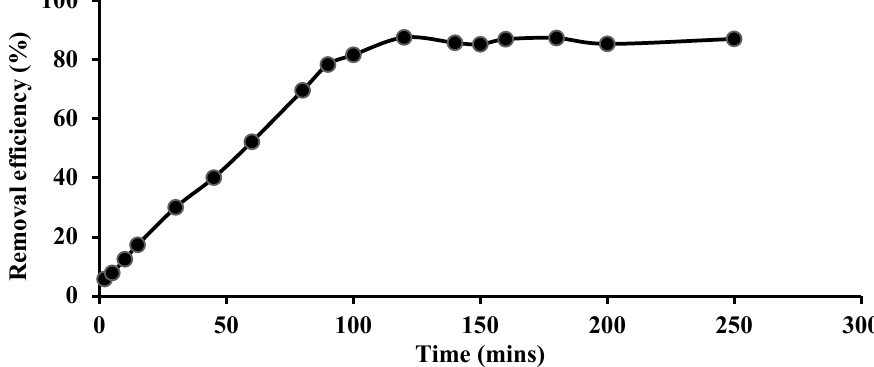
Figure 6. Effect of contact time on Pb(II) ions removal efficiency using Si-TS-SSIL.